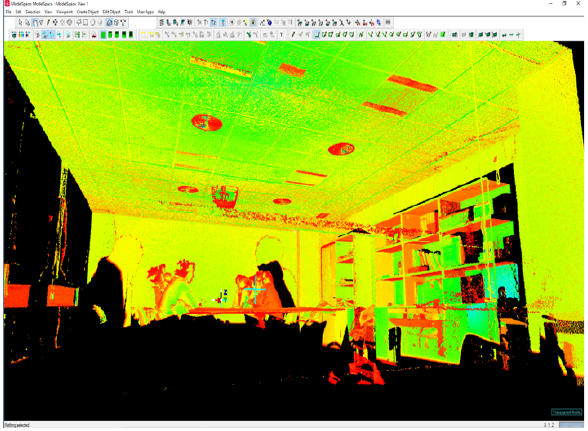
Figure 6. Point cloud of the meeting